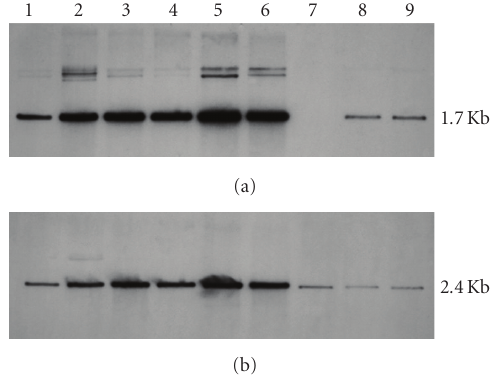
Figure 1: Southern hybridisation of wild-type and BAC clones of C12/130. Southern blots of the Eco RI-digested DNA from the wild- type C12/130 virus and the BAC clones sequentially hybridized with digoxigenin-labelled (a) gpt and (b) meq probe. While the gpt probe detects the specific band in all BAC-derived viral DNA, but not in the wild-type C12/130 virus, meq probe gives positive signals in all the lanes. Band sizes are shown on the right hand side. Lanes (1) pRB-1B5 [4], (2) pC12-130-3, (3) pC12-130-5, (4) pC12-130-8, (5) pC12-130-10, (6) pC12-130-15, (7) wild-type C12-130, (8) virus derived from pC12-130-10, and (9) pC12-130-15.